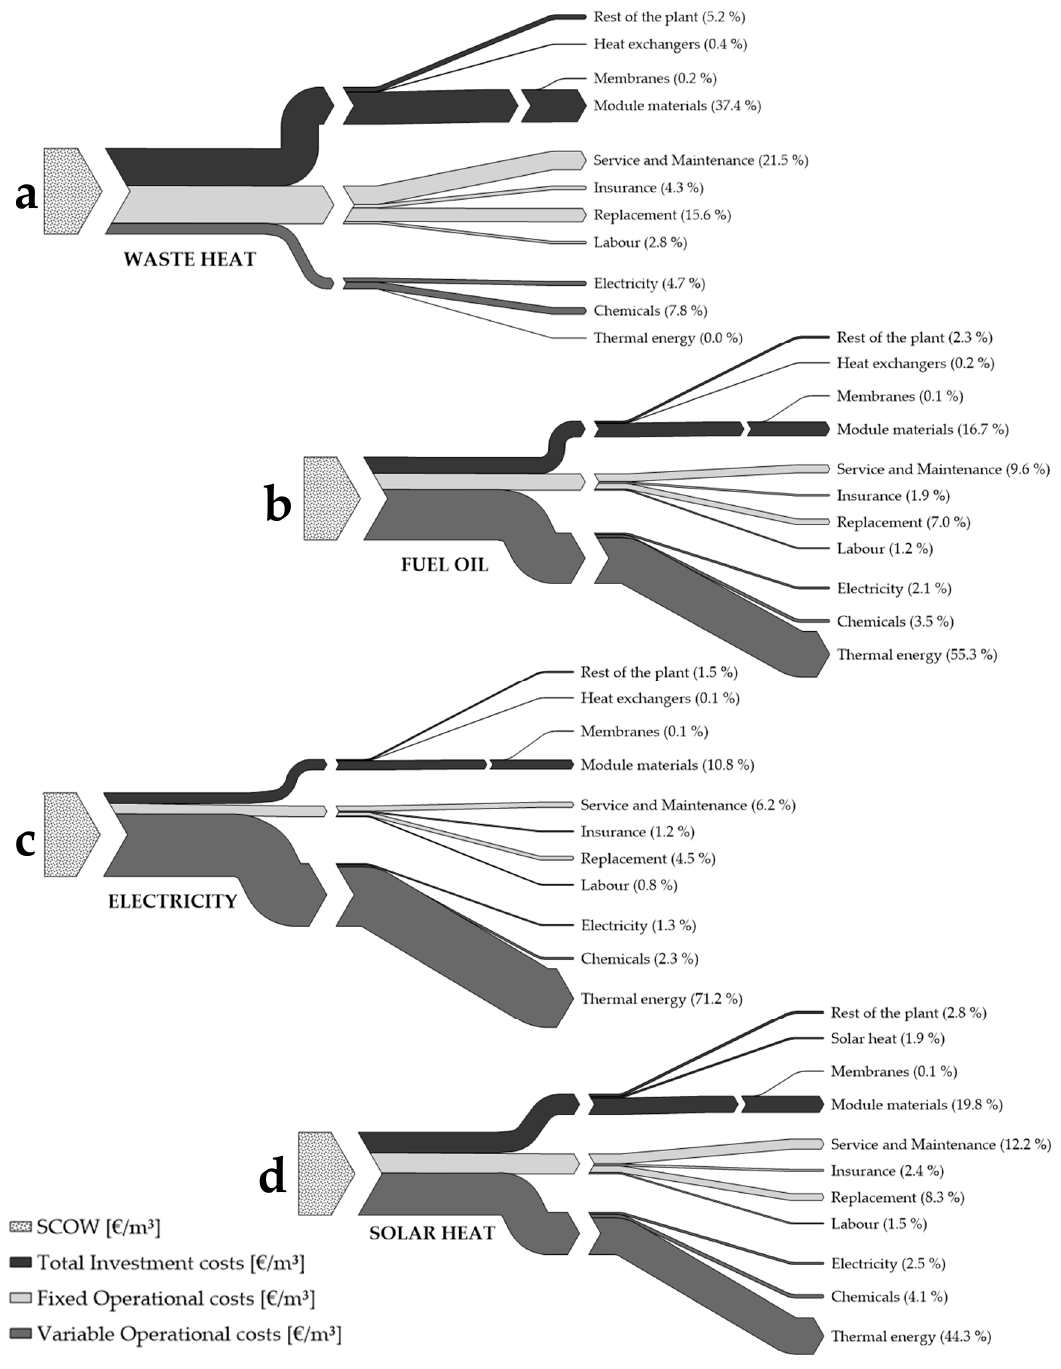
Figure 4. Influence of heat source on the cost of water for a capacity of 1000 m 3 per day and WGMD configuration. ( a ) Waste heat scenario; ( b ) Fuel oil burning scenario; ( c ) Electricity scenario; ( d ) Solar heat scenario.